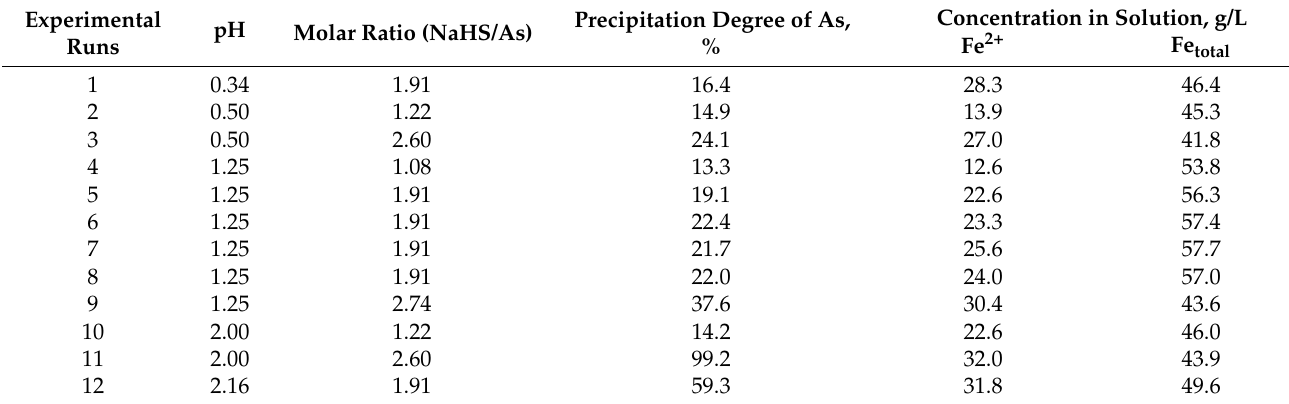
Table 1. Central composite design arrangement and